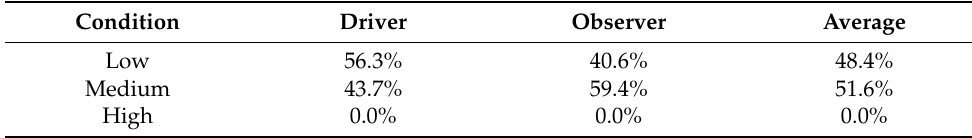
Table 4. Driver versus observer perception of traffic conditions.